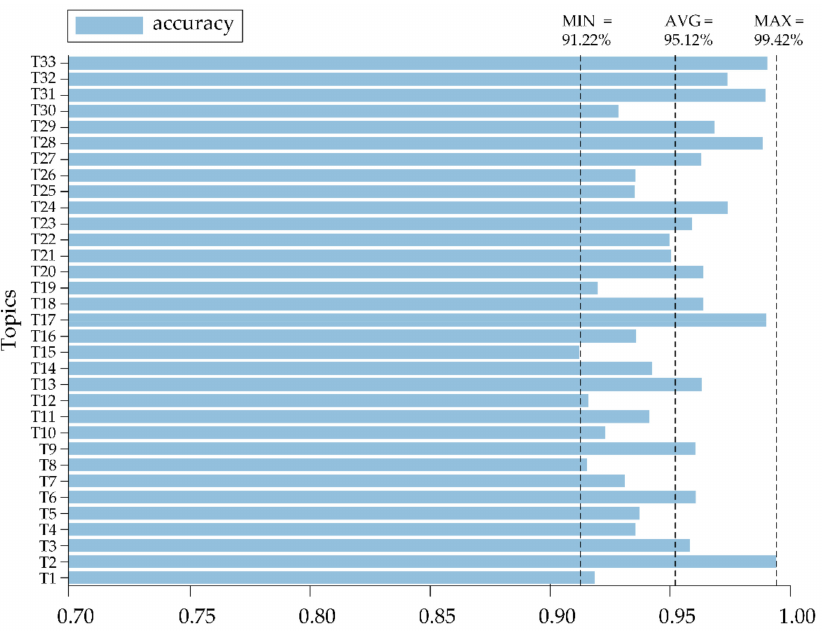
Figure 4. Accuracy of topics classification.